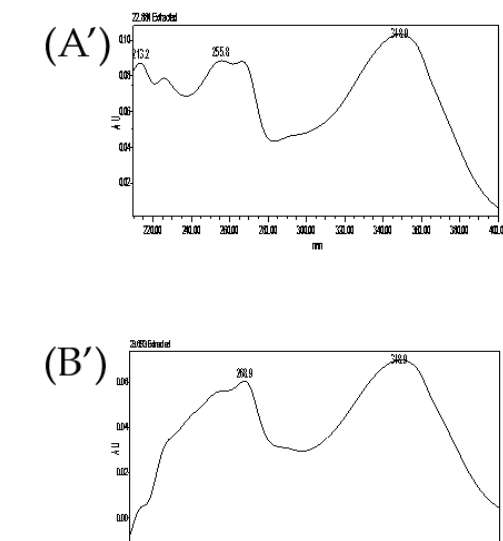
Table 1. Intra-day precision for orientin and isoorientin using the HPLC–PDA method ( n =